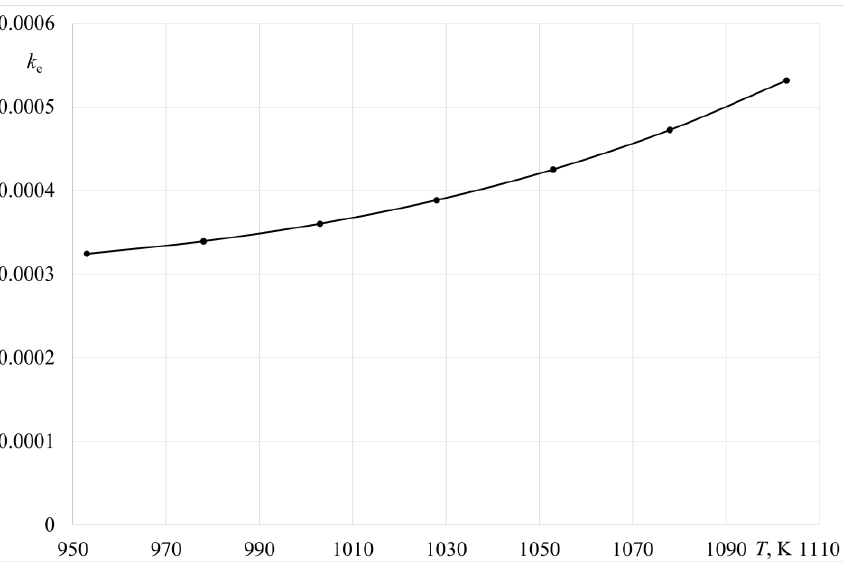
Figure 12. Effects of temperature on the coefficient k eZn value.